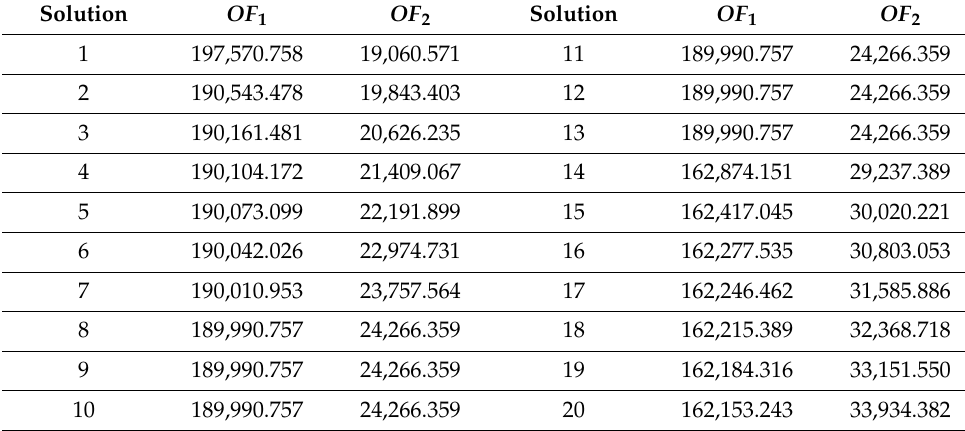
Table 13. Objective function values for the medium-sized test